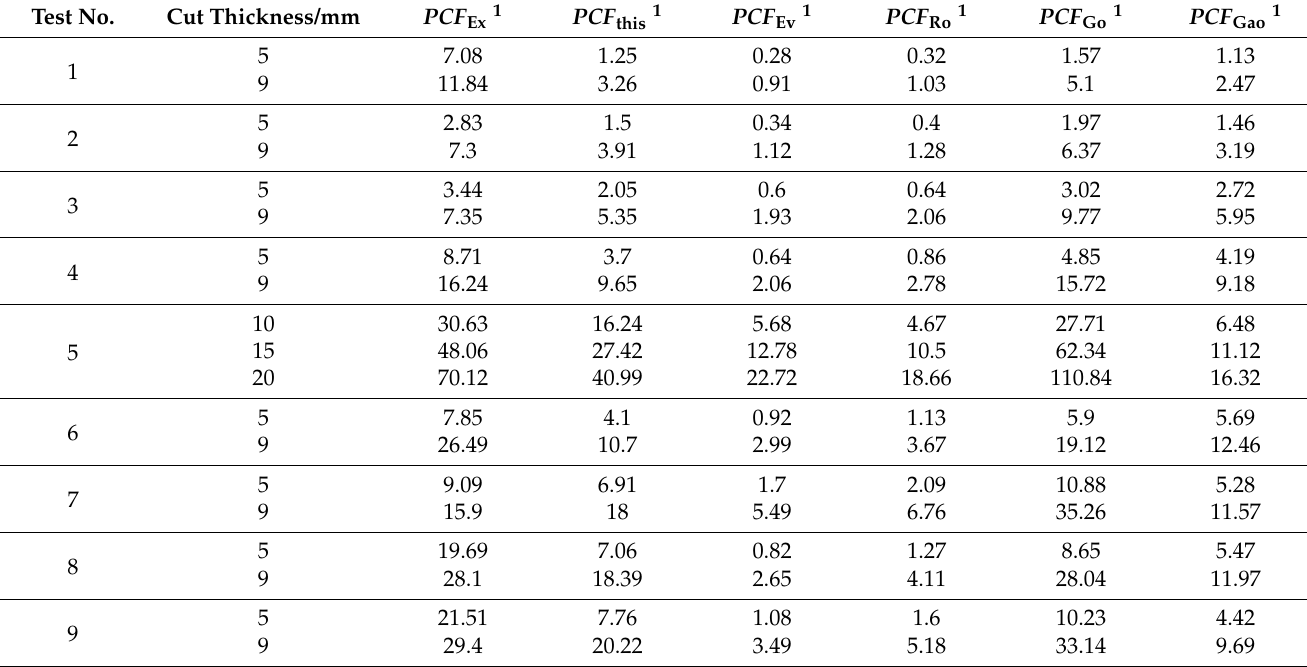
Table 3. PCF obtained by full-scale rock cutting experiments and theoretical models for the first prediction performance